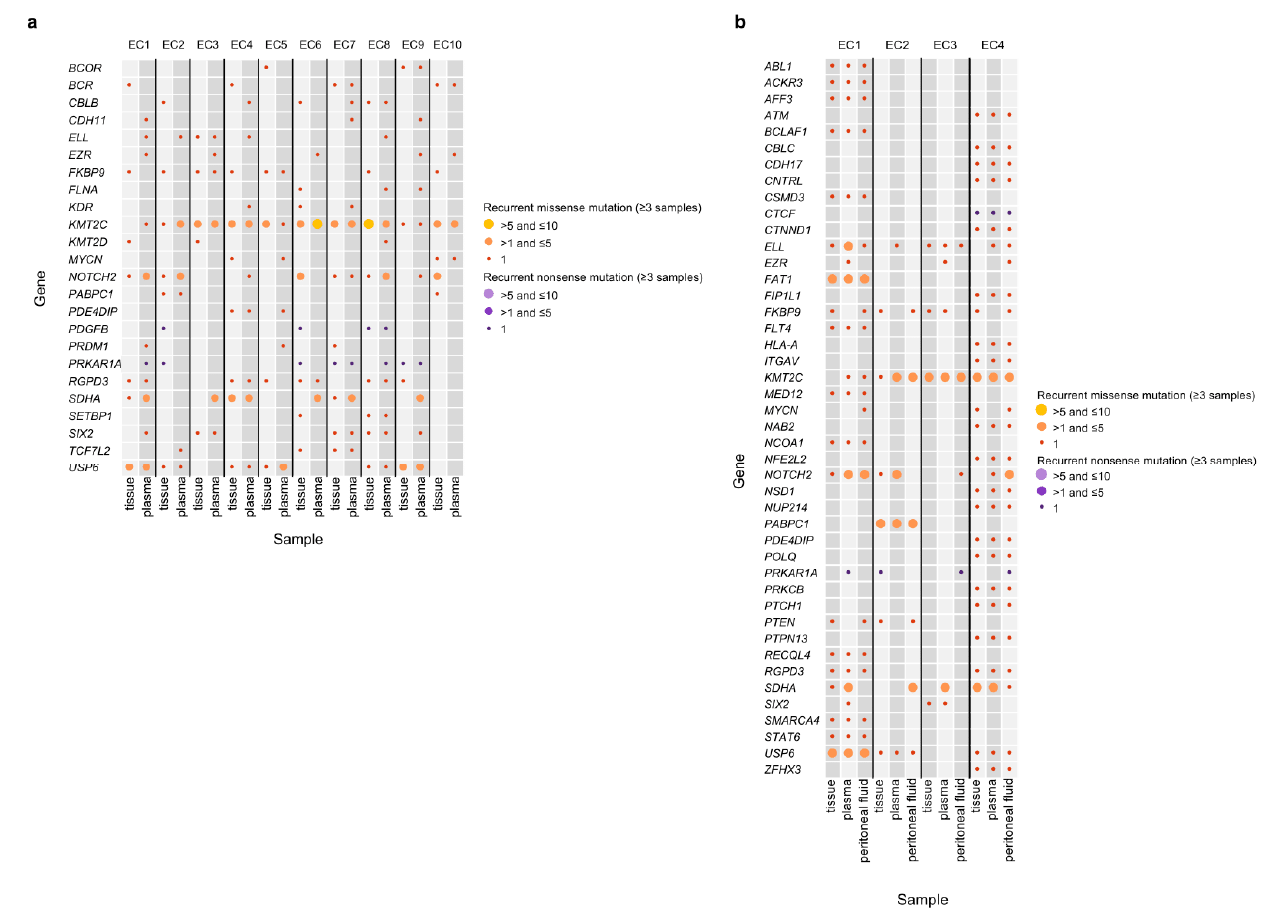
Figure 2. Recurrent somatic mutations ( ≥ 3 samples) in matched tissue and ctDNA samples using 401 cancer-related genes. ( a ) Tissue and plasma samples. ( b ) Tissue, plasma, and peritoneal fluid samples. The size of each dot indicates the number of recurrences. The color of each dot shows the type of somatic mutations. Samples are shown on the x -axis, and genes are listed on the y -axis.